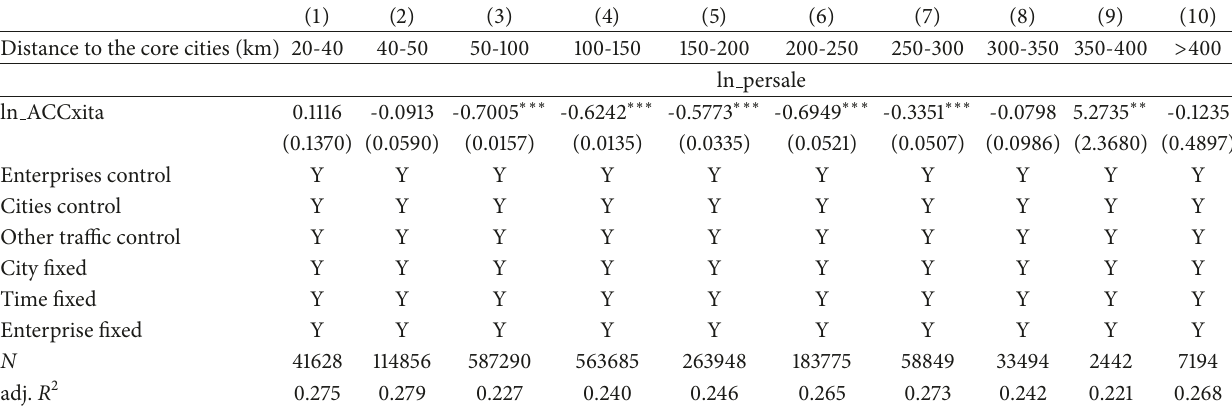
Table 9: The boundary of the influence on the enterprises productivity of peripheral cities.